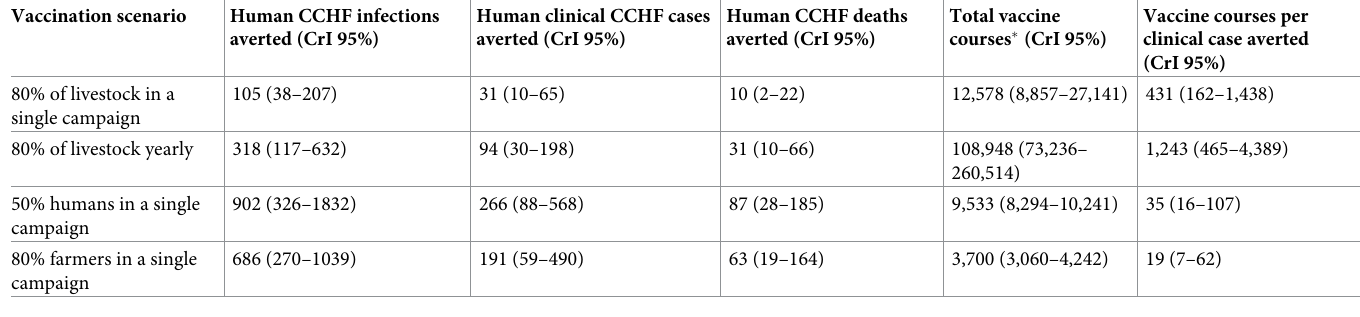
Table 4. Epidemiological impact of modelled vaccination strategies. CCHFV Infections and early deaths averted, and number of vaccine courses per clinical case averted, according to the four vaccination scenarios, cumulatively over the period April 2014 to Dec 2018. Vaccination